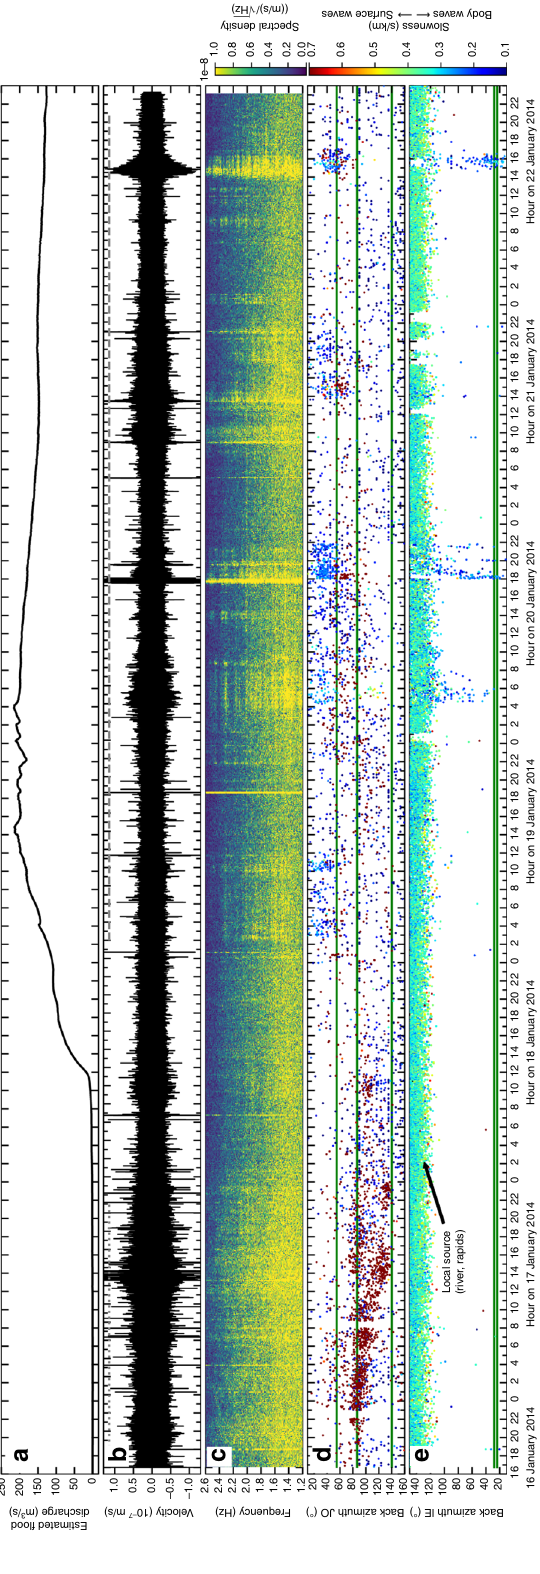
sub-glacial fl oods. The ability to track the direction and speed of fl ood propagation can serve as a subglacial fl ood early-warning tool. However, unequivocal determination of the initiation time of the propagating fl ood does require some careful considerations (see section “ Practical applications and outlook ” in “ Discussion ” ).